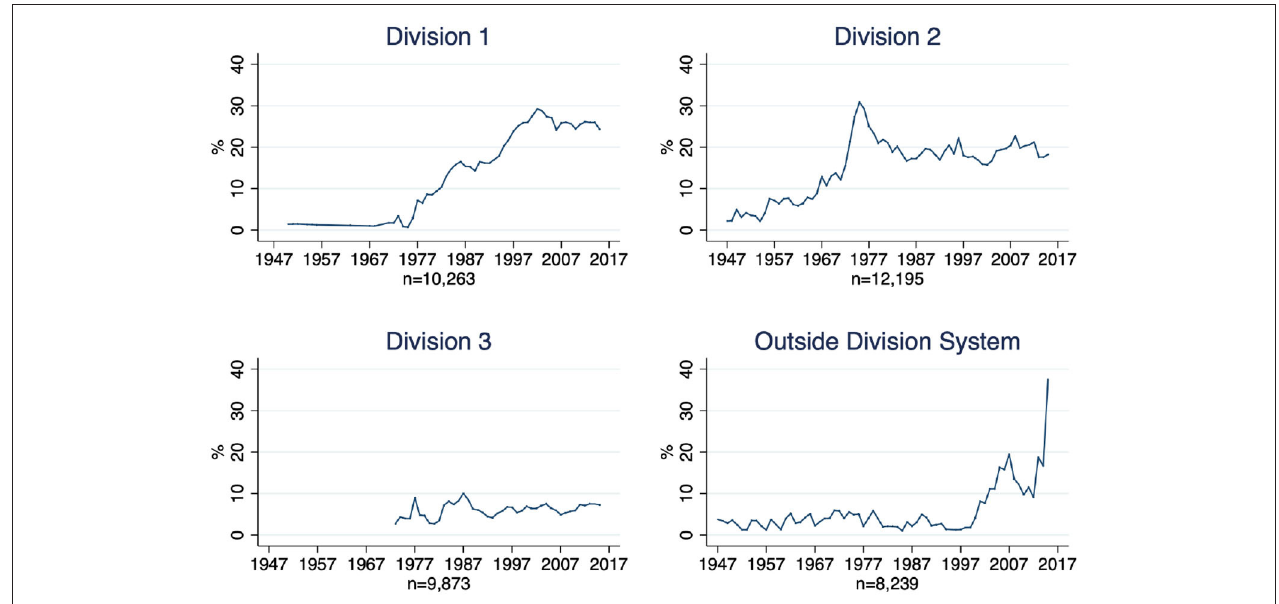
FIGURE 4 | Black coaches in